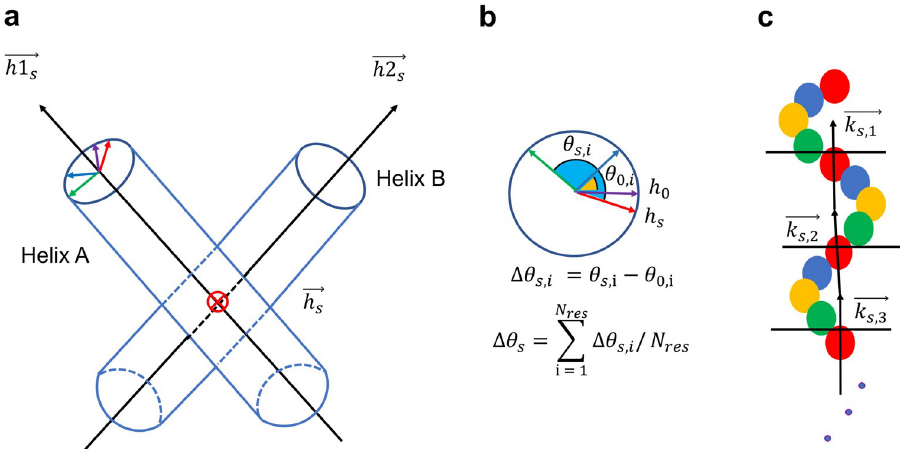
Fig 3. Schematic illustrations of the strategies for defining helix rotational angles. (a) Axes of helix A and helix B, and the cross product of the two axes as the reference for rotation. (b) Definitions of residue-specific rotations and the final helix rotation. (c) Definitions of { k s , j } for handling helix bending and